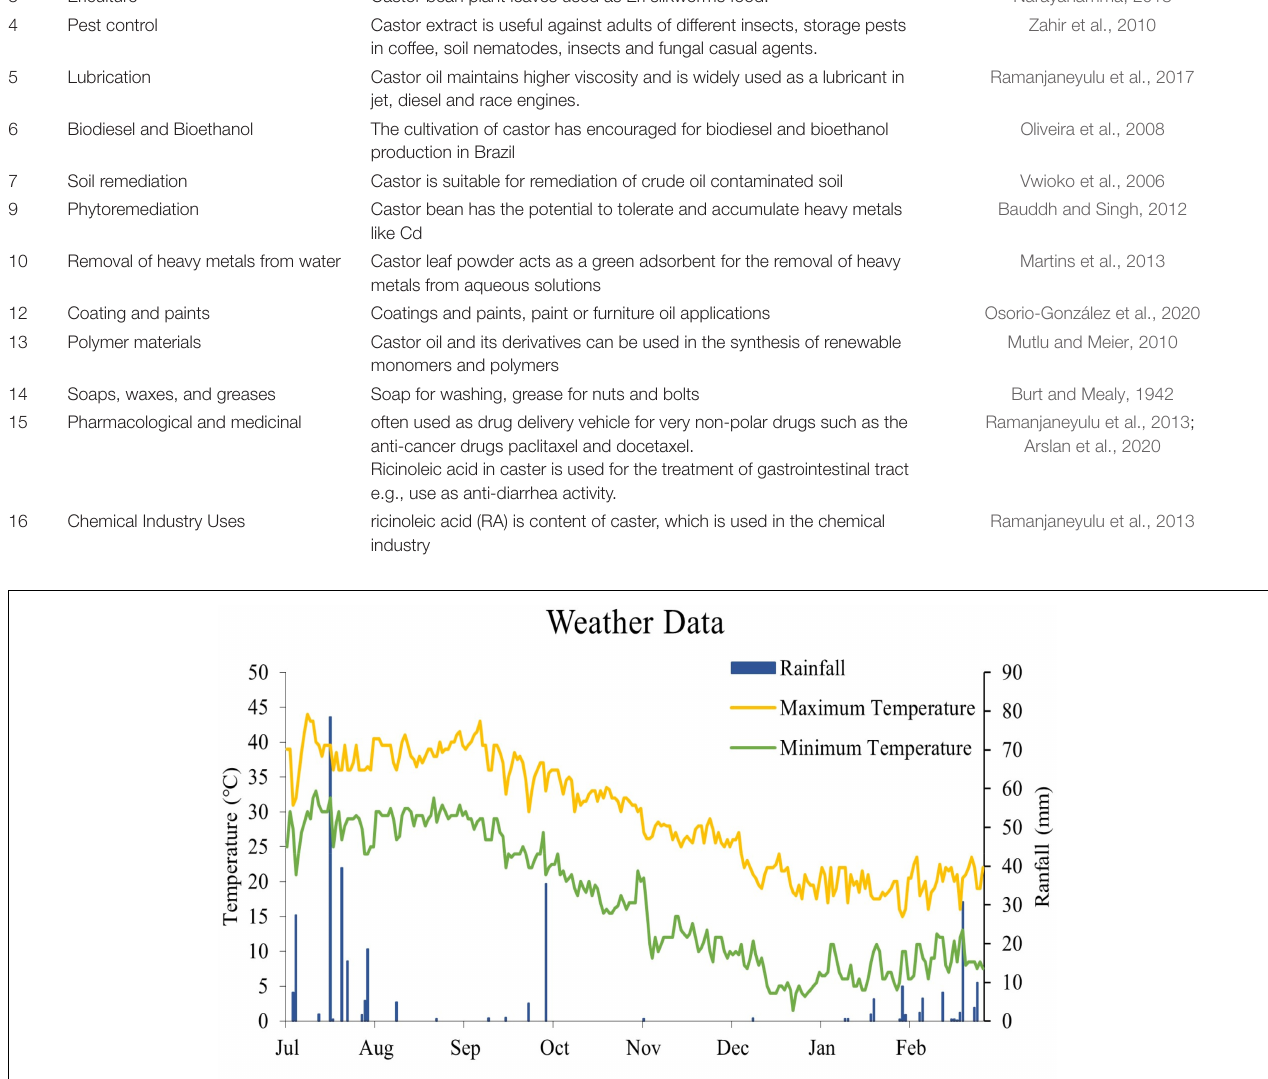
In respective plots (or treatments), S was applied as gypsum (CaSO 4 .2H 2 O) with first irrigation. Totally, three irrigations of 4 acre-inch were applied according to crop requirements on the 2nd week after germination, at flowering and at seed filling. The crops were harvested at